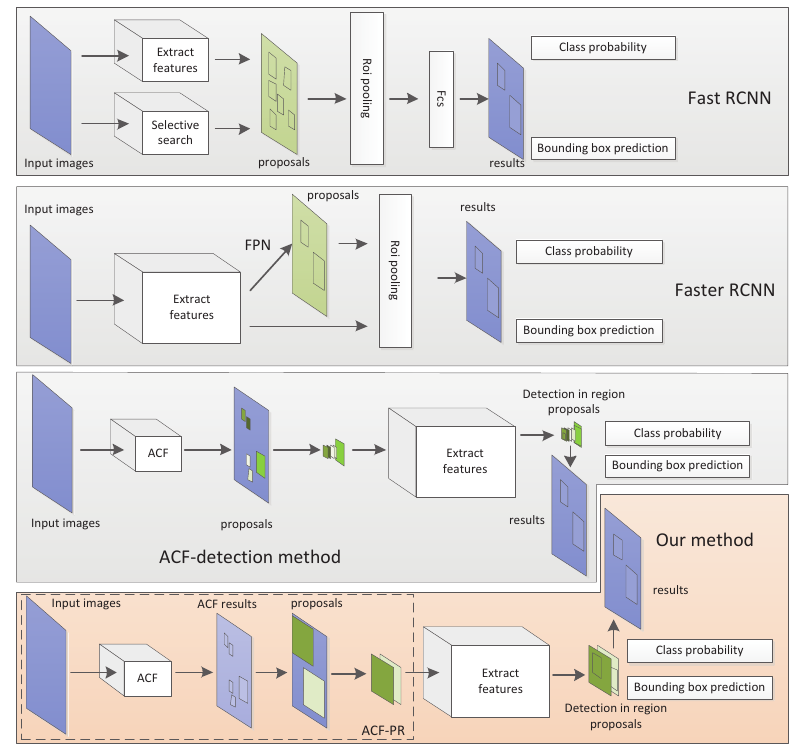
Figure 4. The structure of our method and other